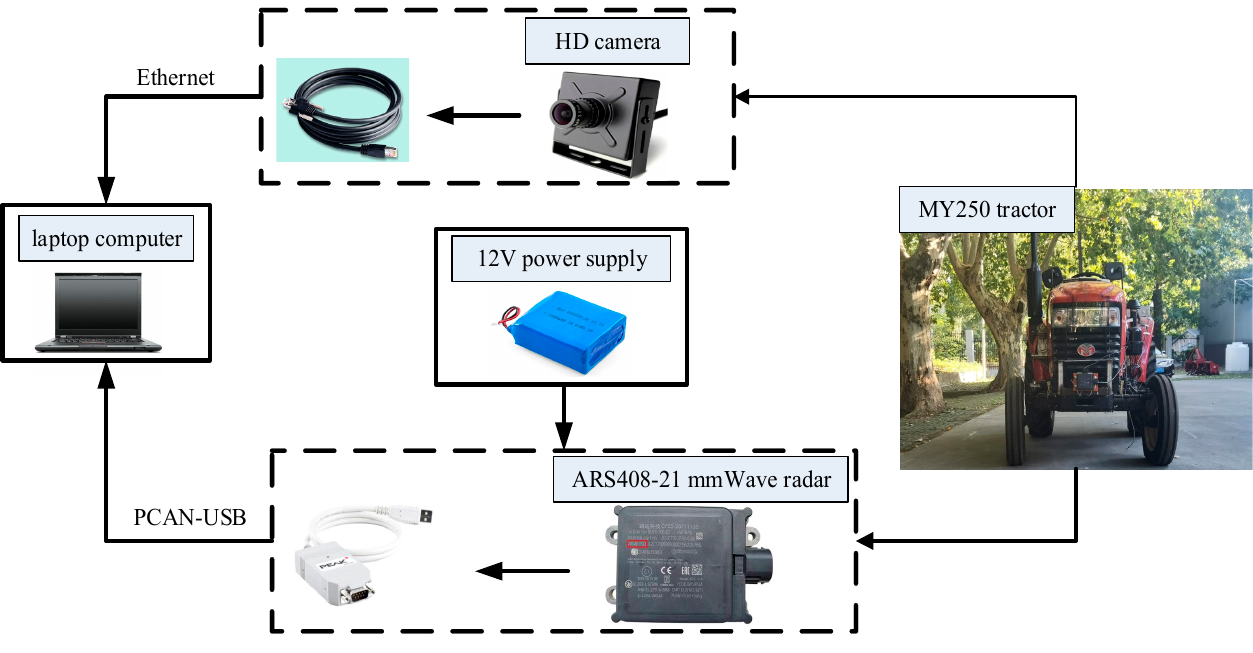
Figure 9. Experimental configuration.